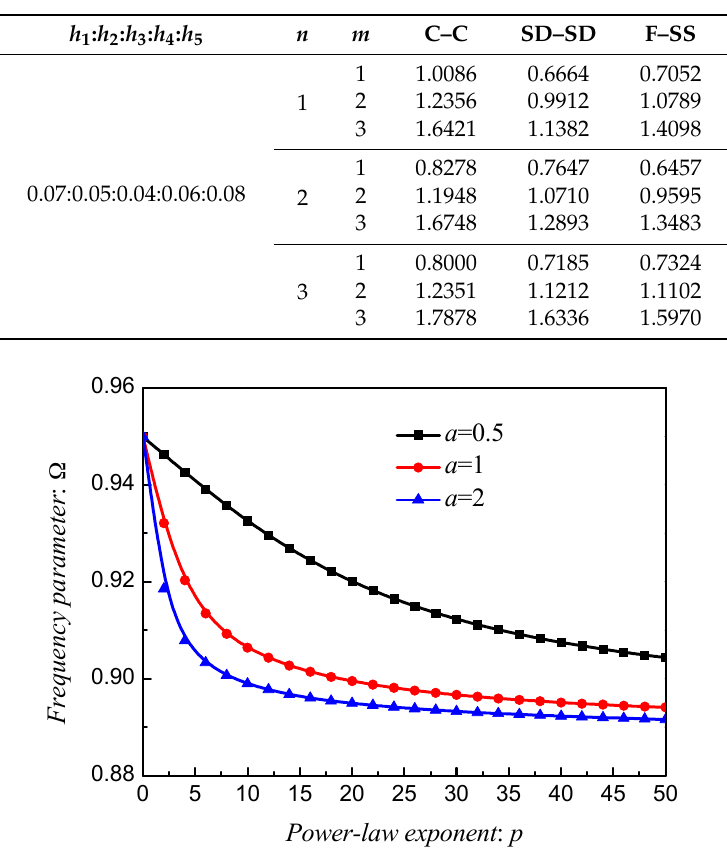
Figure 12. Results about different p and c of stepped FGM I ( a = 1; b = 0.5; c ; p ) paraboloidal shell. Figure 13. Results about different E c / E m and p of stepped FGM I ( a = 1; b = 0.5; c = 2; p ) paraboloidal shell.